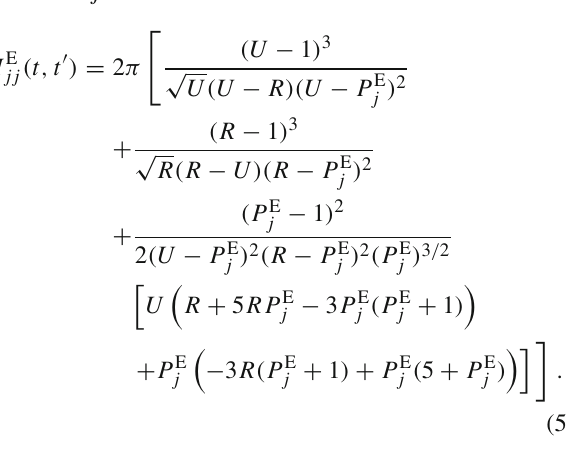
Fig. 15 Effective form factors squared corresponding to G BN ( t ) (see Eqs. (51) to (53)) and compared to ( G BO G BN M while for j = k one